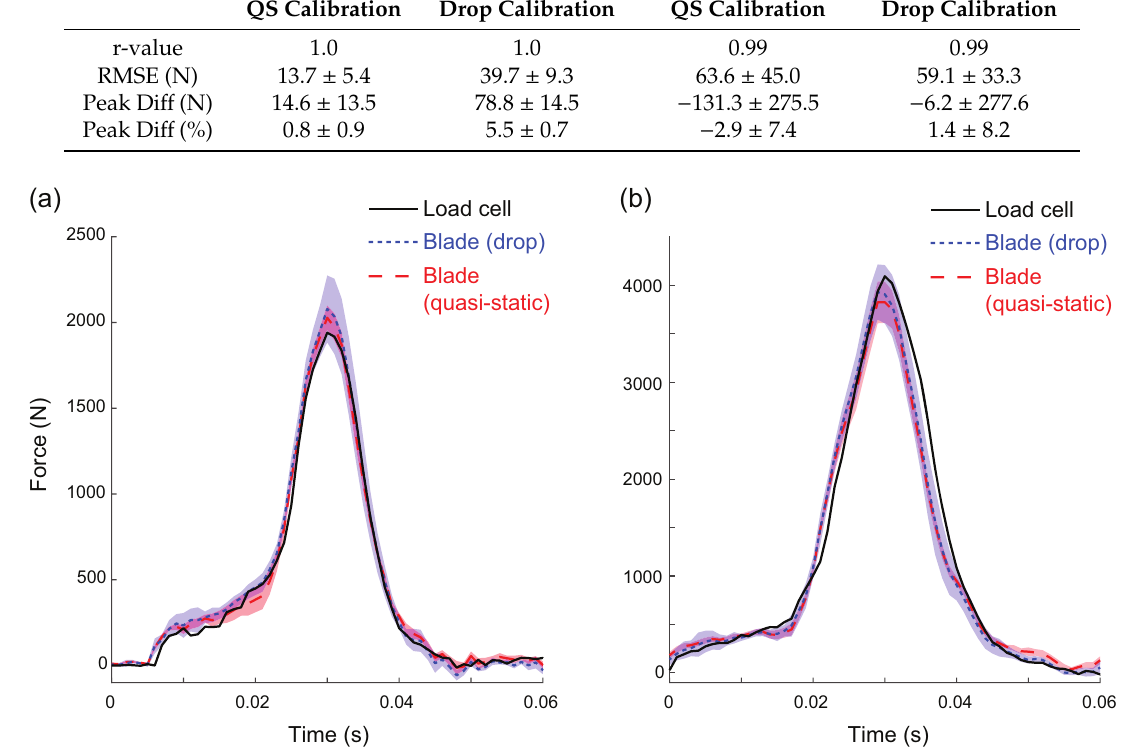
Figure 7. Blade and load cell (LC) forces from two representative drop trials—one with a low weight ( a ) and the other at a high weight ( b ). Blade forces were estimated using either Quasi-static (QS) or Drop (Drop) calibrations. Each of the nine calibration matrices created for each loading condition were applied to the blade data, resulting in nine estimates of force. The lines associated with blade data represent the means of these estimated forces, and the shaded areas represent the standard deviation of the nine estimates of force. In this example, the QS calibration was slightly more accurate on the low force trial and the Drop calibration was slightly more accurate on the higher force